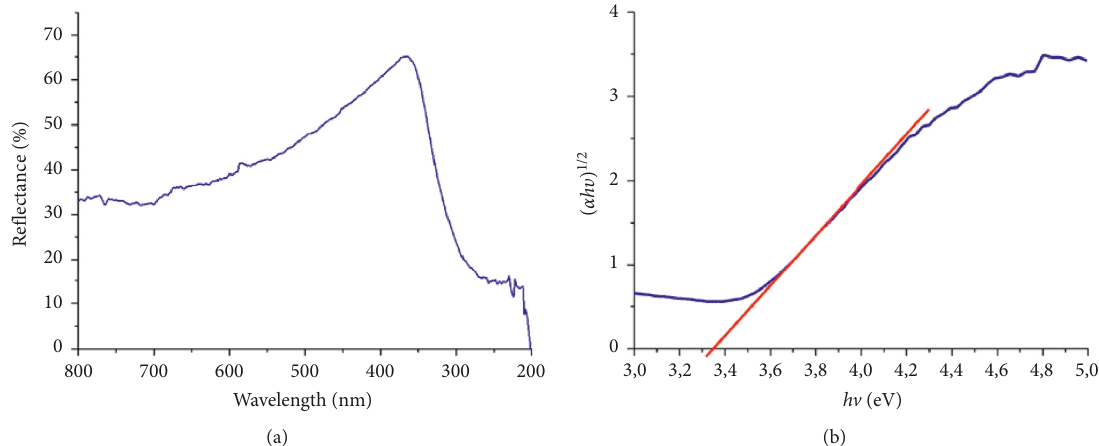
Figure 10: Diffuse reflection spectra of the nanostructured sodium niobate (a) and the extrapolation of the NaNbO plot